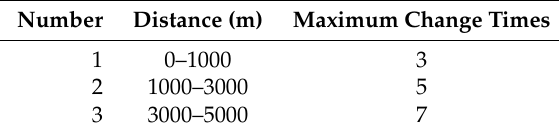
Table 4. Constraints for the driving regimes’ change times.